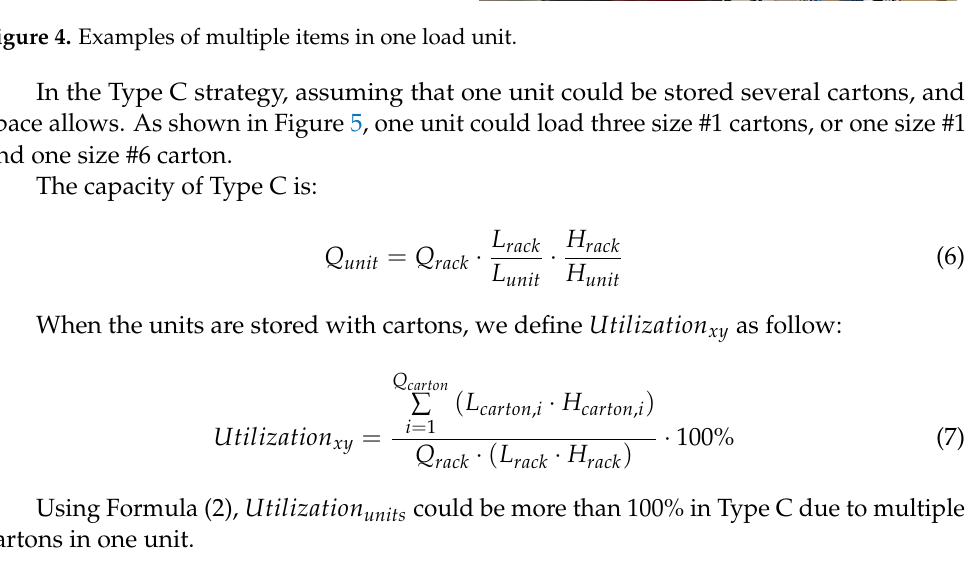
Figure 5. The side view of Type C racks. The capacity of Type C is: